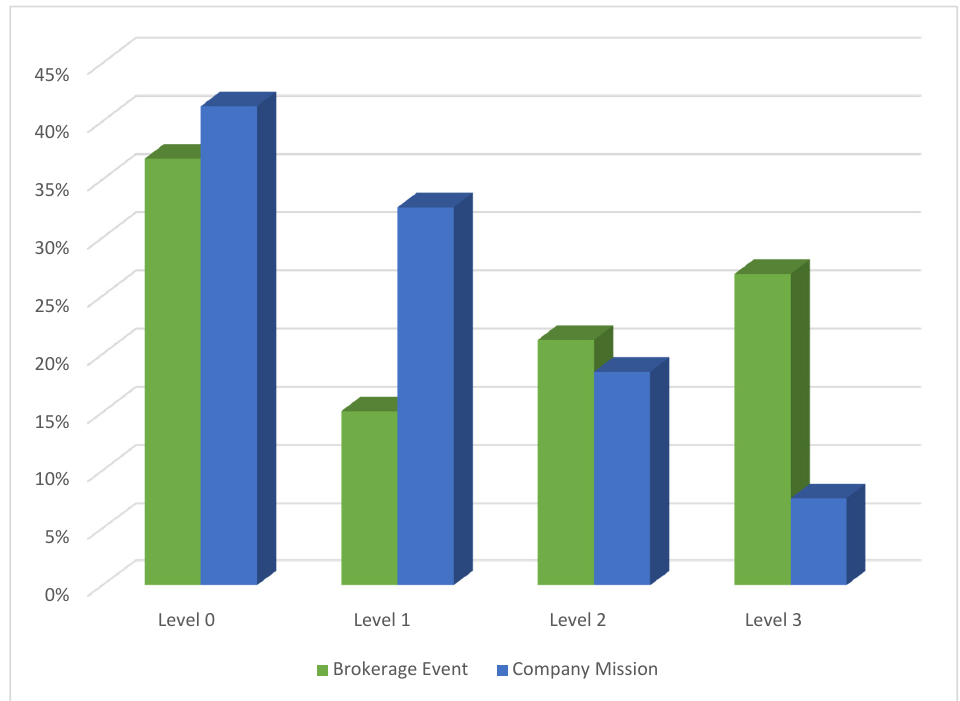
Figure 6. The percentage distribution of the analyzed events across specific levels as per the number of partnerships, depending on the type of event. Source: own study.